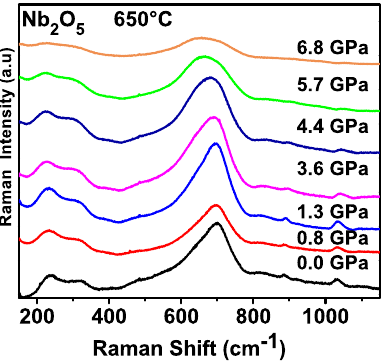
Figure 8. Raman spectra of Nb 2 O 5 obtained by the sol-gel method at 650 ◦ C (NH 4 OH)) as function of the hydrostatic pressure, recorded at room